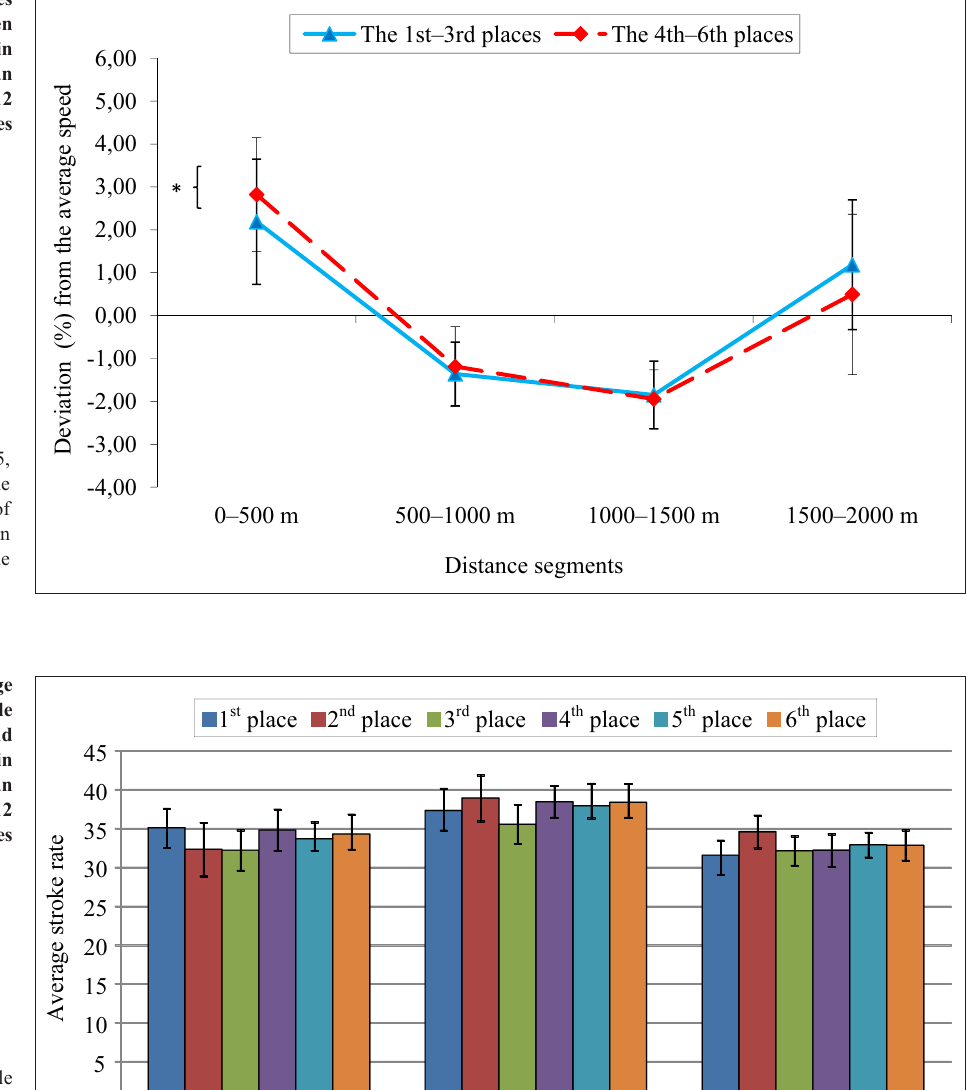
Figure 2. The average pace of men single sculls, double sculls and women single sculls in final A at the European championship 2012 according to the places taken